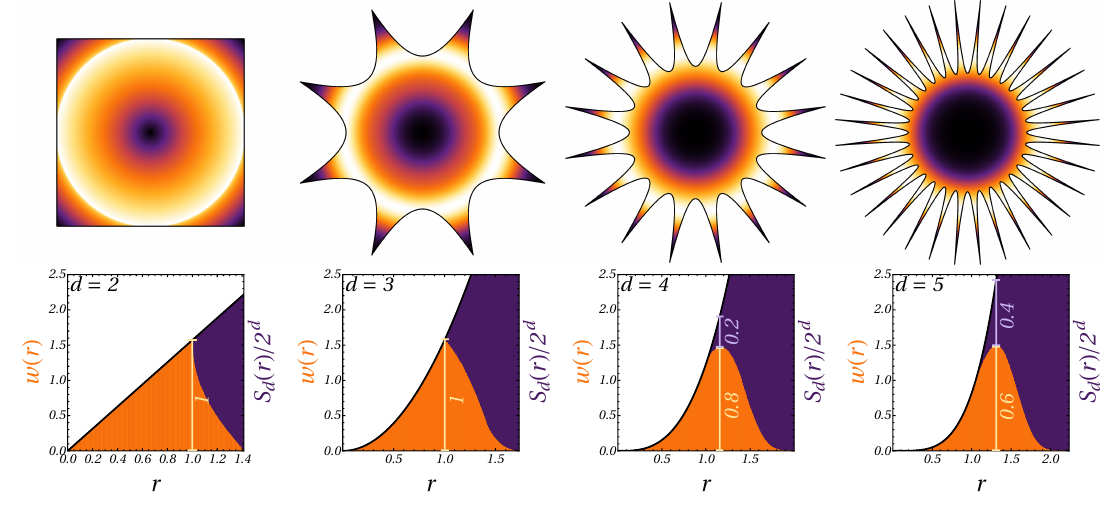
Figure 2: High-dimensional volumes. Top: 2 d sketches of hypercubes in d = 2 , 3 , 4 , and 5. The outer black line √ links vertices located at a distance d from the center of the cube to midpoints located on the unit hypersphere with hyperbolic lines. The inside of each shape is colored with a density plot of the relative contribution w ( r ) of each radial shell inside the cube to the full volume, as obtained from Monte Carlo integration using 10 6 points uniformly drawn inside each cube. Bottom: Histograms of relative weights of radial shells w ( r ) for the hypercube (orange) and for the hyperball (purple). The lines highlight how large the intersection of the cube and a hyperspherical shell is at the distance that contains most of the cube’s volume. As reminded in the insets, this intersection here represents 1 , 1 , 0 . 78 , and 0 . 62 times the surface of the full hyperspherical shell,